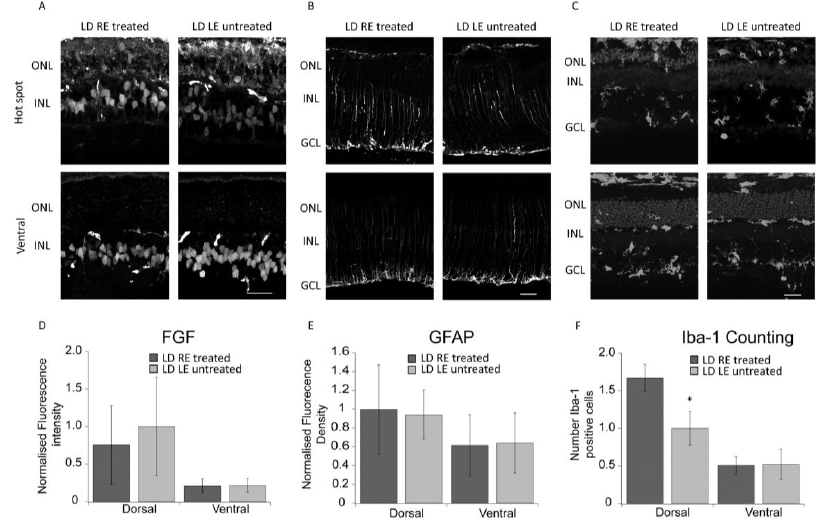
Figure 3. CBS treatment reduces microglia migration in the ONL. ( A ) Treated (LD RE treated) and untreated (LD LE untreated) retinas marked for FGF2. The upper panel shows the “hot spot” area in the dorsal retina, the bottom panel, a representative portion of the ventral retina. ( B ) Treated (LD RE treated) and untreated (LD LE untreated) retinas marked for GFAP. The upper panel shows the “hot spot” area in the dorsal retina, the bottom panel, a representative portion of the ventral retina. ( C ) Treated (LD RE treated, black) and untreated (LD LE untreated, gray) retinas marked for IBA-1. The upper panel shows the “hot spot” area in the dorsal retina, the bottom panel, a representative portion of the ventral retina. ( D ) FGF2 levels, measured in the ONL, in both treated (LD RE treated, black) and untreated (LD LE untreated, gray) retinas. ( E ) GFAP levels, measured along with the entire thickness of the retina, of treated (LD RE treated, black) and untreated (LD LE untreated, gray) retinas. ( F ) The number of microglial cells in the ONL of treated (LD RE treated, black) and untreated (LD LE untreated, gray) retinas (* p < 0.05). Scale bars in panel A, B, and C = 30 µm.